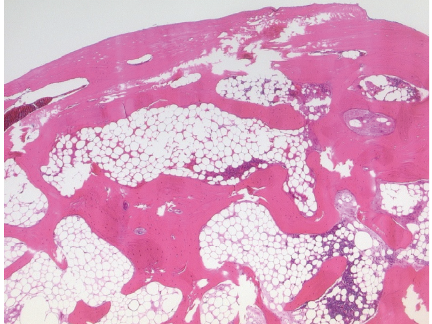
Figure 3: Histopathological appearance of the lesion (haematox- ylin and eosin staining, magnification 10x). Beneath the sur- rounding compact bone, the structure consists of cancellous bone tissue with regular medullary